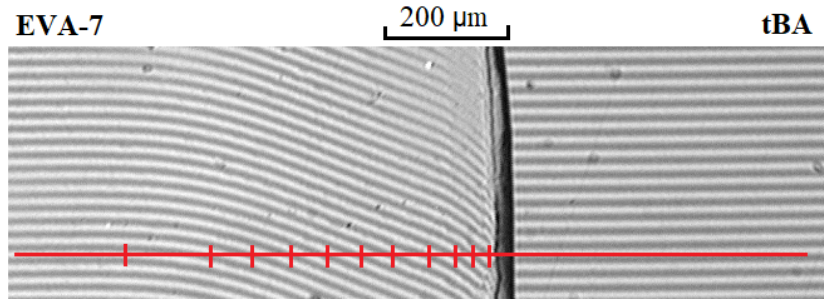
Figure 1. Interferogram of the interdiffusion zones of EVA-7–tBA at temperature 75 ◦ C and diffusion time 16 min. Explanation of the figure in the text.